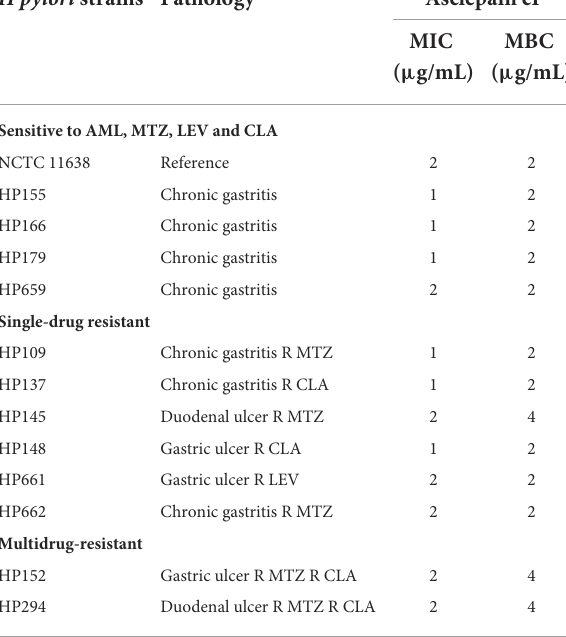
TABLE 4 Minimum inhibitory concentration (MIC) and minimal bactericidal concentration (MBC) of asclepain cI against H. pylori strains by means of the broth micro dilution